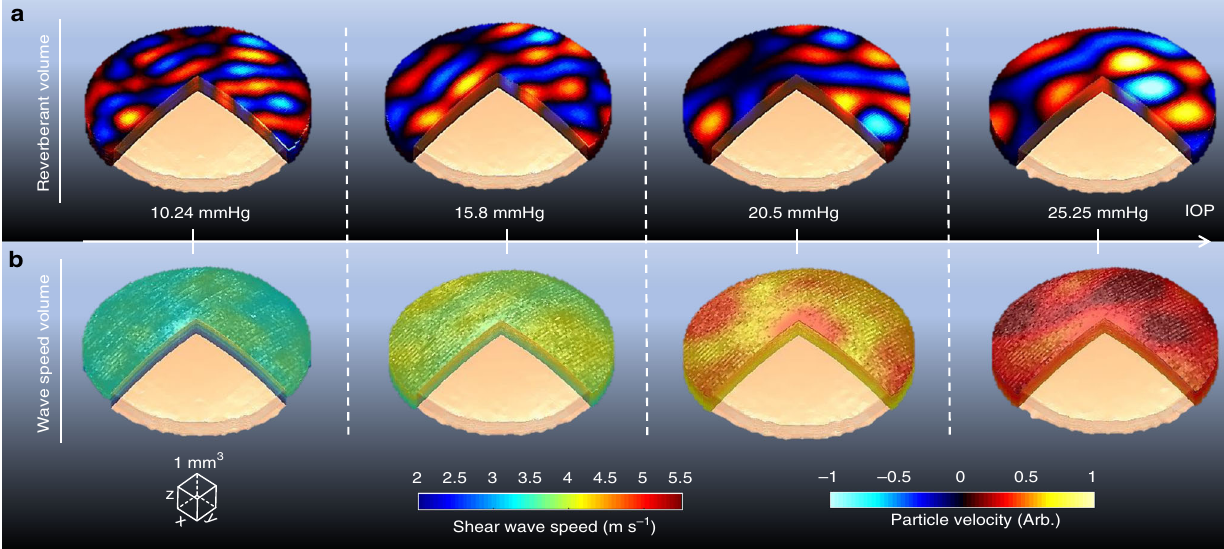
Fig. 5 Volumetric analysis of ex vivo IOP-controlled porcine corneas using Rev3D-OCE. a Particle velocity reverberant volumes of cornea subjected to four IOP levels: 10.24, 15.80, 20.50, and 25.25 mmHg. Particle velocity frames are extracted, following the curved shape of the cornea at all depths, and processed using auto-correlation (2 × 2 mm 2 window size) and fi tted to Eq. (2) for the estimation of local wavenumber ( k (cid:4) ). b Shear wave speed volumes of the cornea for each IOP case calculated using c s = ω 0 / k (cid:4)